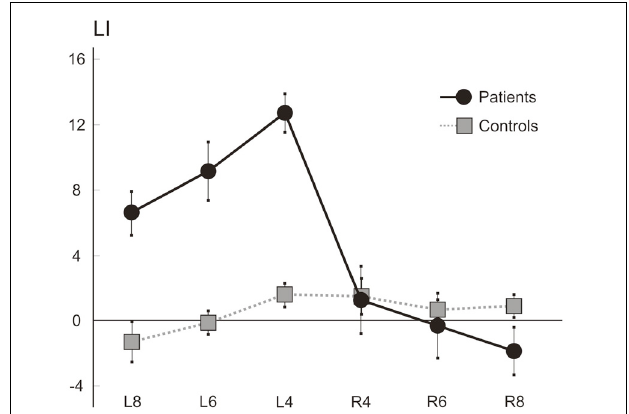
FIGURE 7 | Line extension task. Mean (s.e.m.) LIs of the seven right brain patients and six control participants for rightward (R) and leftward (L) extended lines (length: 4, 6, and